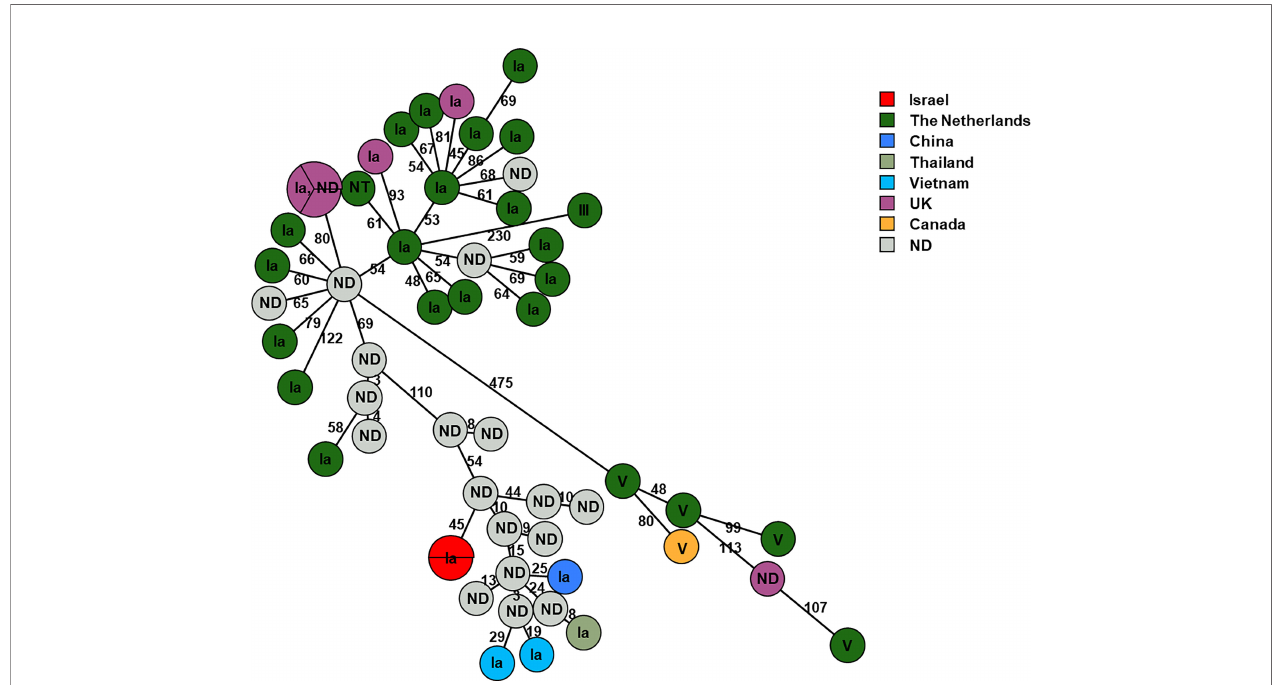
FIGURE 3 | Whole genome MLST phylogenetic analysis of 55 publicly available global ST-7 sequences. Minimum spanning tree was based on wgMLST scheme (2,207 genes). The numbers on branches indicate allelic differences between strains. Group B Streptococcus (GBS) serotype is shown on top of the nodes. Color- coding is by country of origin ND = no data available regarding the serotype of the